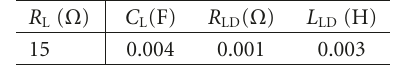
Table A.7: Parameters of a rectifier load of test system 2.